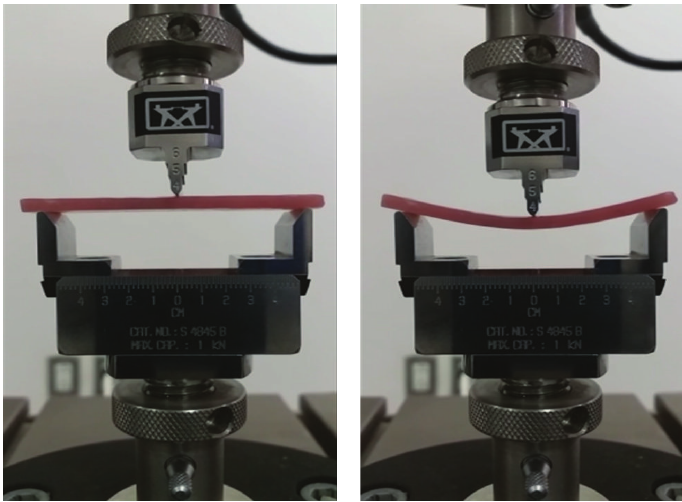
Figure 1: Acrylic resin specimen loaded on universal testing machine and subjected to fracture load.